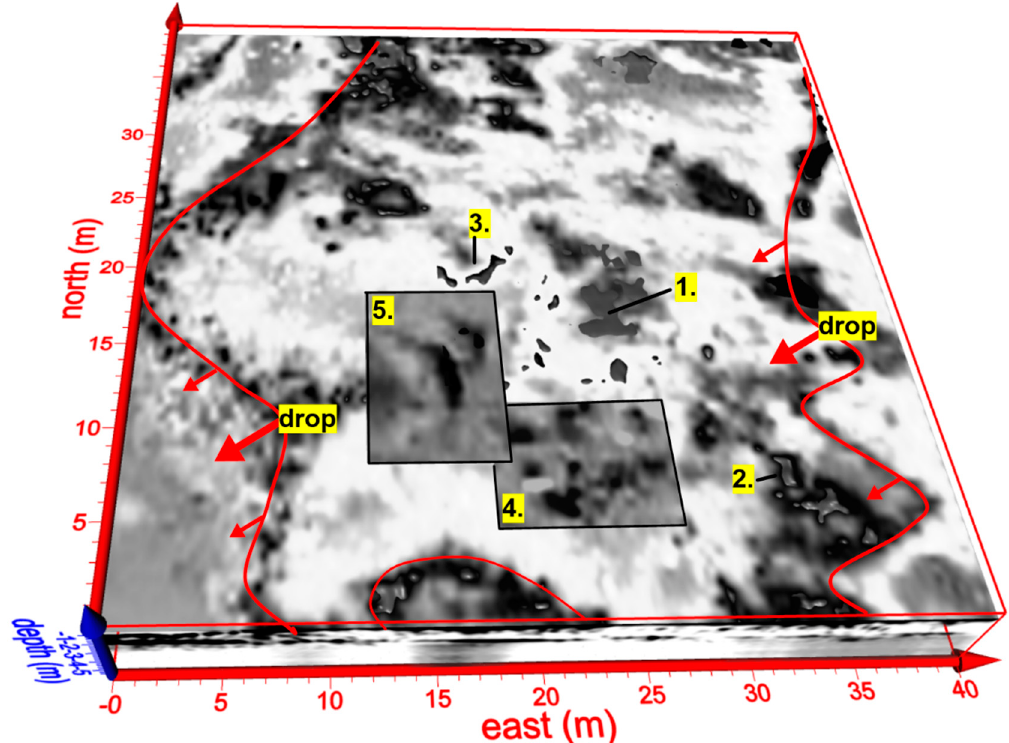
Figure 15. Interpretation. (1) The location of four known skeletal components (ulna, humerus, rib, vertebra) clearly coincides with a cluster of GPR anomalies of various sizes; (2) The known location of two additional vertebrae also coincides with a cluster of GPR anomalies; (3) Several anomalies west of the main cluster on known skeletal components are suggestive in form of additional bones; (4) A cluster of anomalies on a plane just above the lake bottom exhibits several velocity/polarization oddities that may be related to frozen vegetation and/or trapped gas pockets along with additional bones; (5) Also shown on a plane just above the lake bottom, and perhaps most suggestive, is a pair of anomalies that exhibit forms consistent with tusks. All of these anomalies seem to be settled on (or embedded in) the lake bottom on a generally flat area located in between a shallow drop-off in the east (about a 25 cm drop) and a sloping drop in the west of somewhat greater magnitude.